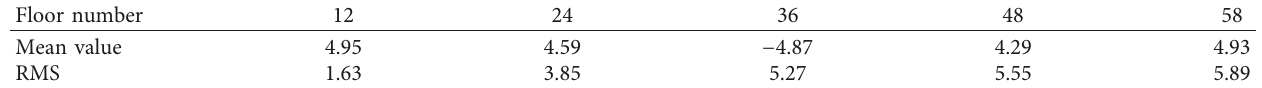
Table 12: Mean errors and RMS errors for wind load estimation.